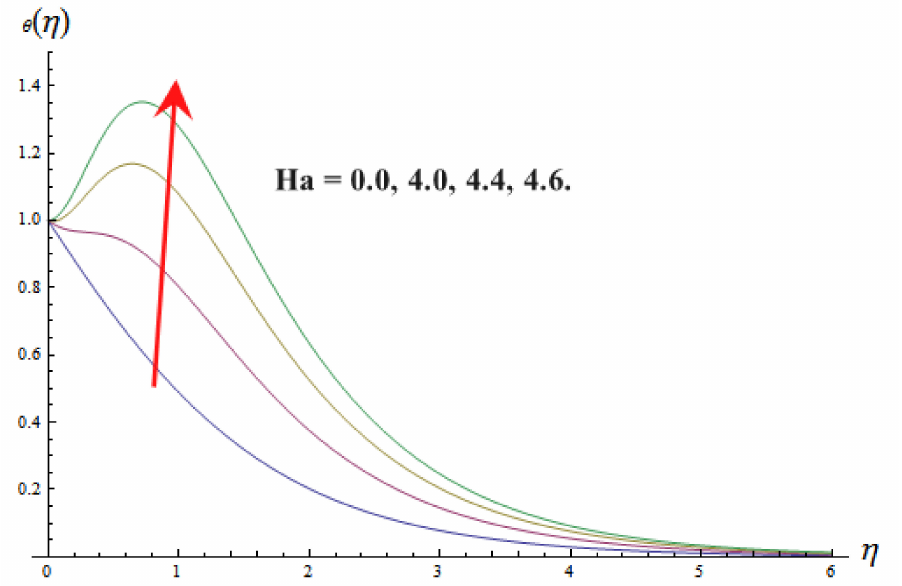
Figure 9. Impact of Ha on θ ( η ) keeping Γ = 0.5, Pr = 2, Br = 2, λ = 2, Ec = 0.2, Rd = 2, β 1 = 0.2, λ 1 = 0.2, K ∗ =